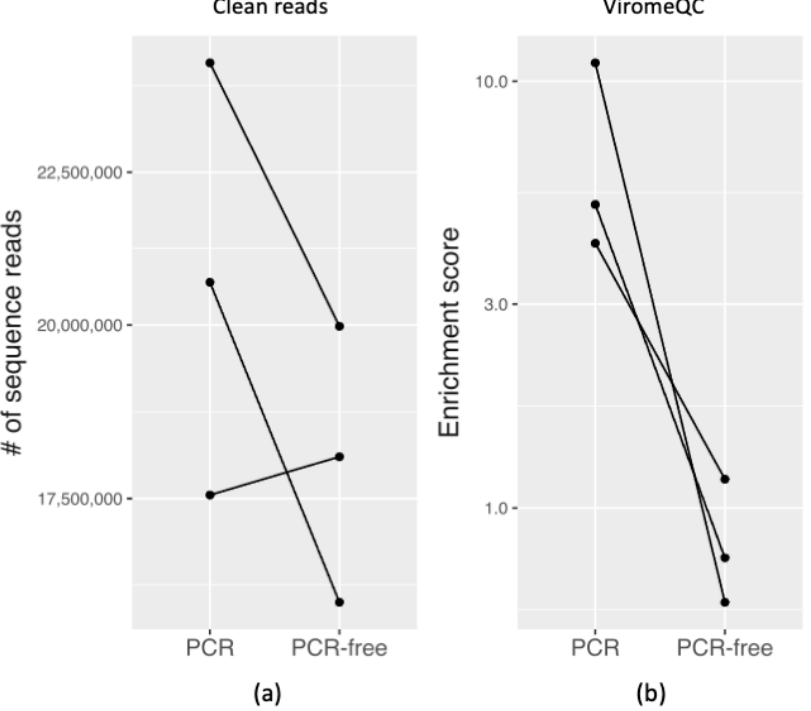
# represents “number” or “number of”.